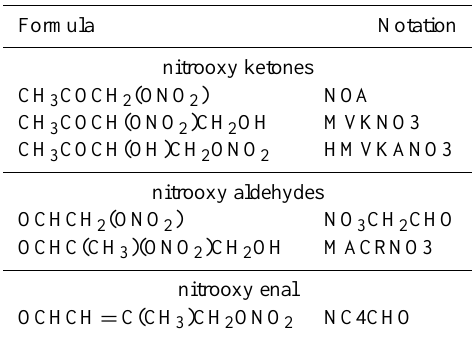
Table 1. Isoprene-derived carbonyl nitrates considered in this